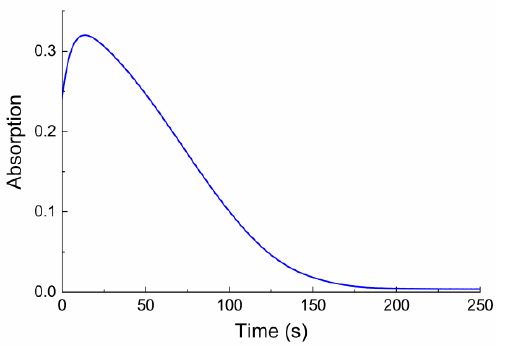
Figure 5. Kinetics of photodegradation of 22 upon UV irradiation through a UFS-1 light filter, recorded at 605 nm.